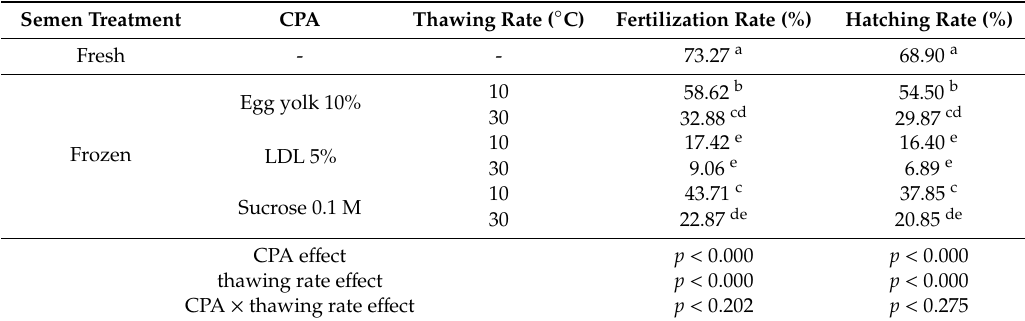
Table 2. Fertilization ability of fresh semen or frozen semen in presence of the three non-permeating cryoprotectants and two di ff erent thawing